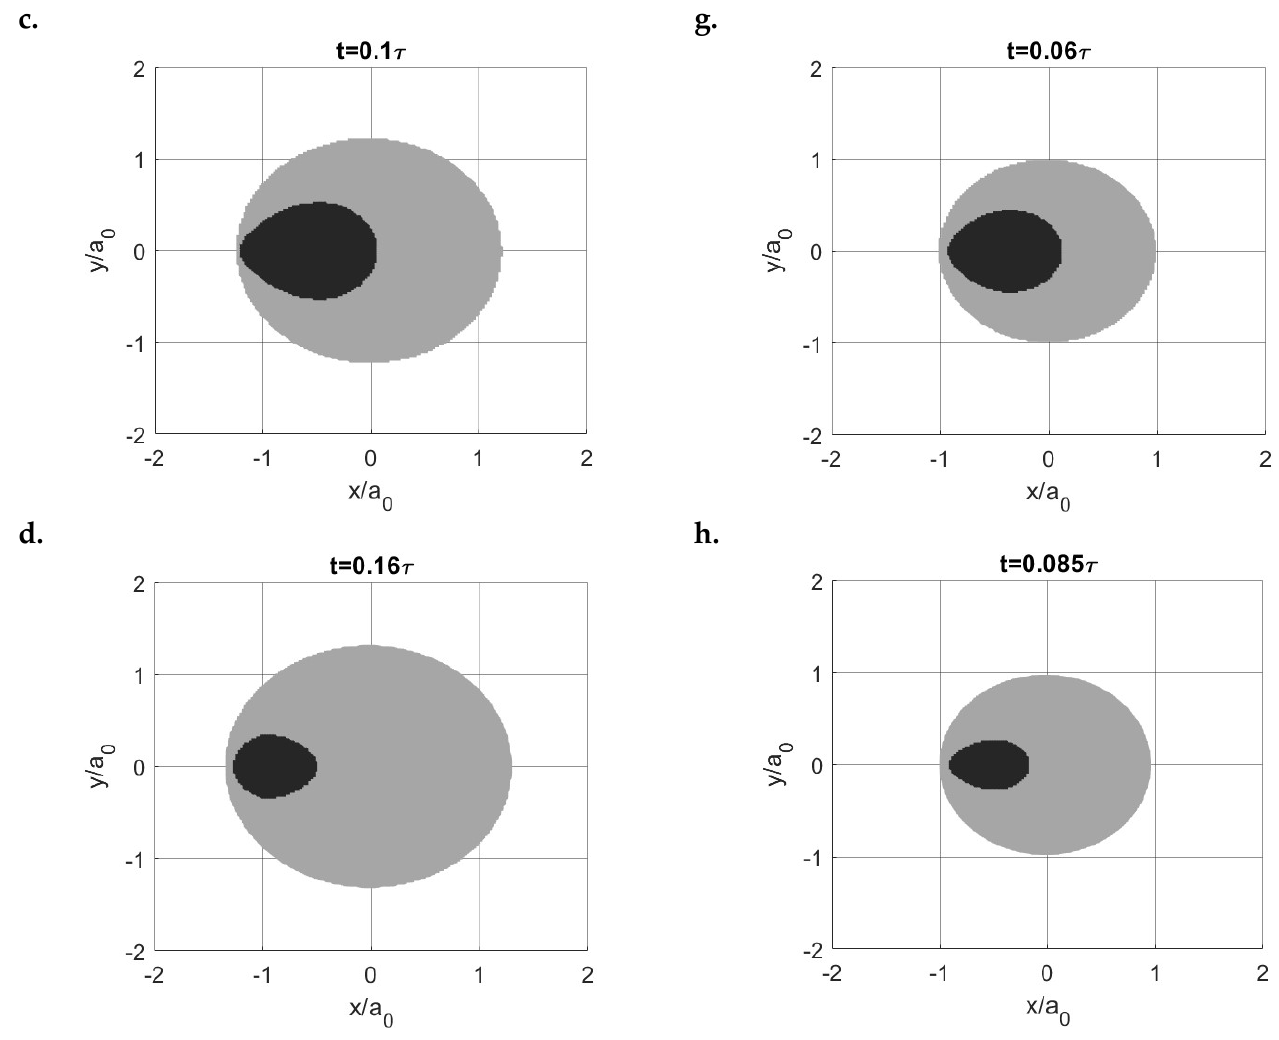
Figure 27. Fully coupled solution regarding the evolution of the stick (dark) and slip (grey) regions for the creep case ( a – d ) and relaxation case ( e – h ).